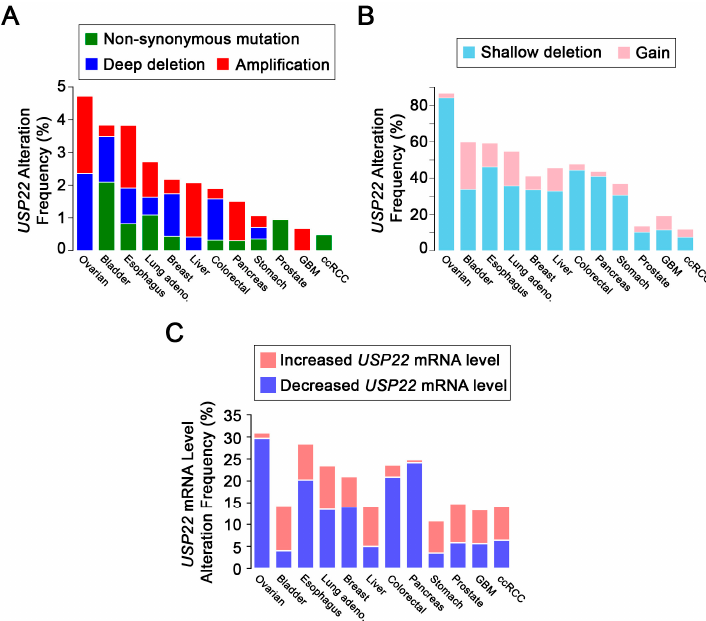
Figure 3. Frequencies of USP22 alterations in cancers evaluated by The Cancer Genome Atlas (TCGA) [37]. ( A ) Mutations, deep deletions (i.e., heterozygous loss) and amplifications are observed at low frequency. ( B ) Shallow deletions (i.e., heterozygous loss) and gains of USP22 are frequent events in many cancer types. ( C ) Frequencies of cases for each cancer type with increases (pink) or decreases (blue) in USP22 mRNA expression (z-score ± 1.5). Lung adeno: Lung adenocarcinoma; GBM: Glioblastoma Multiforme; ccRCC: clear cell Renal Cell Carcinoma. All data are from TCGA [37,43–51].